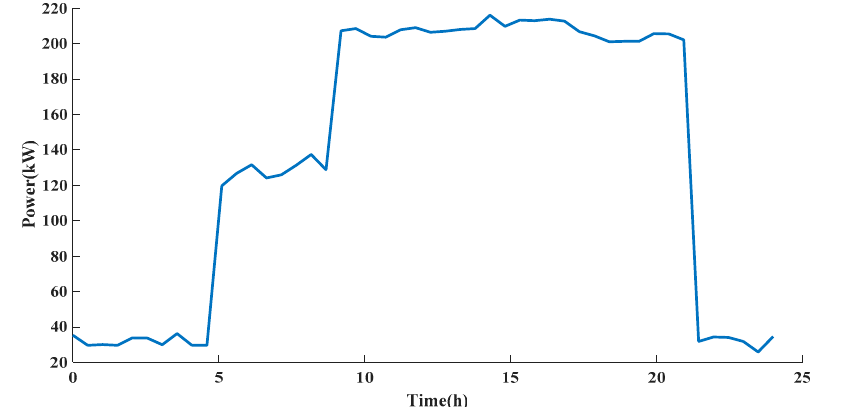
Figure 4. Building load demand.